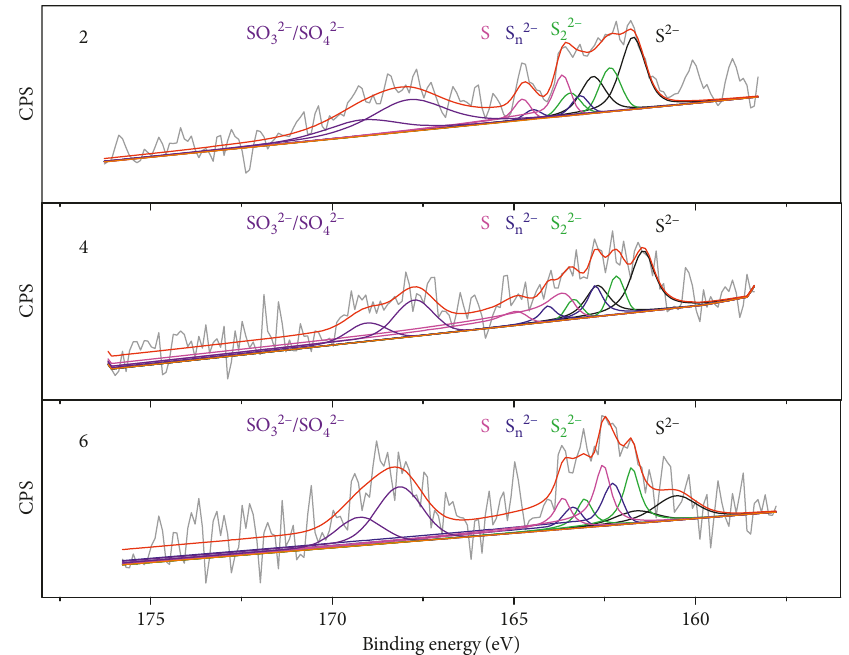
Figure 10: S2p Spectra of CuO adsorption with and without different